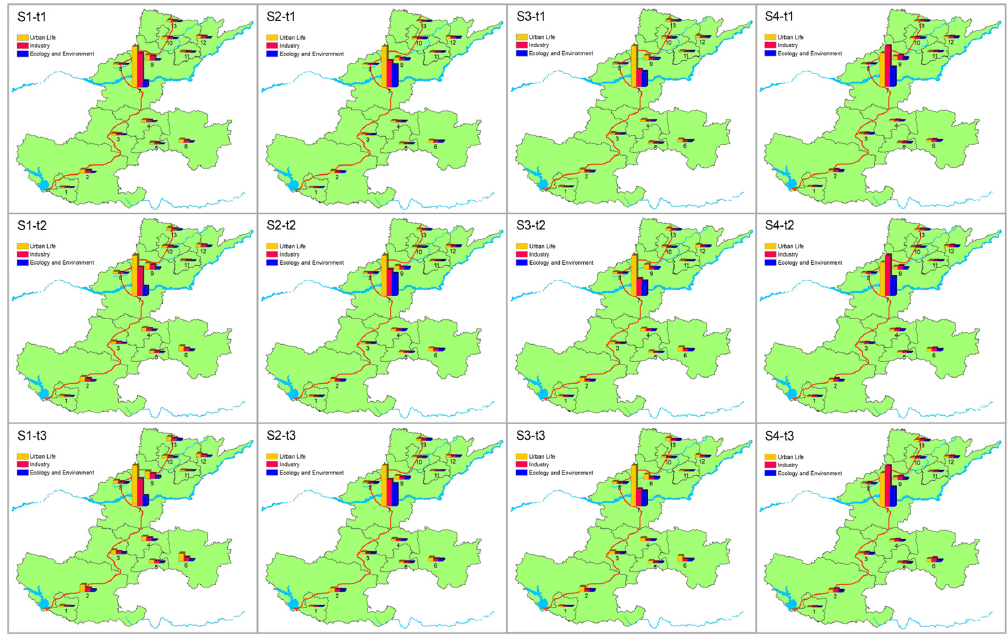
Figure 4. Allocated water under different scenarios in different departments and different periods (10 6 m 3 ). Note: S1, Scenario 1; S2, Scenario 2; S3, Scenario 3; S4, Scenario 4; t1, period 1; t2, period 2; t3, period 3; 1, Dengzhou City; 2, Nanyang City; 3, Pingdingshan City; 4, Xuchang City; 5, Luohe City; 6,